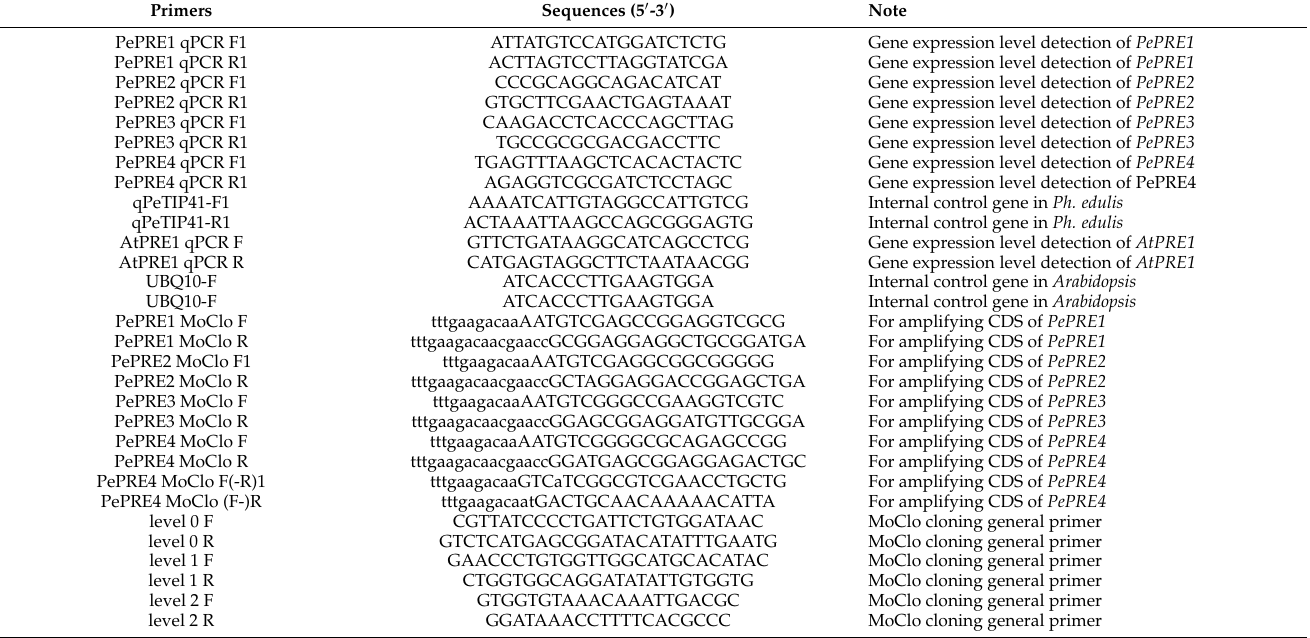
Table A1. The primers used for quantitative PCR (RT-qPCR) and amplification of full-length coding sequences of PePREs in Phyllostachys edulis